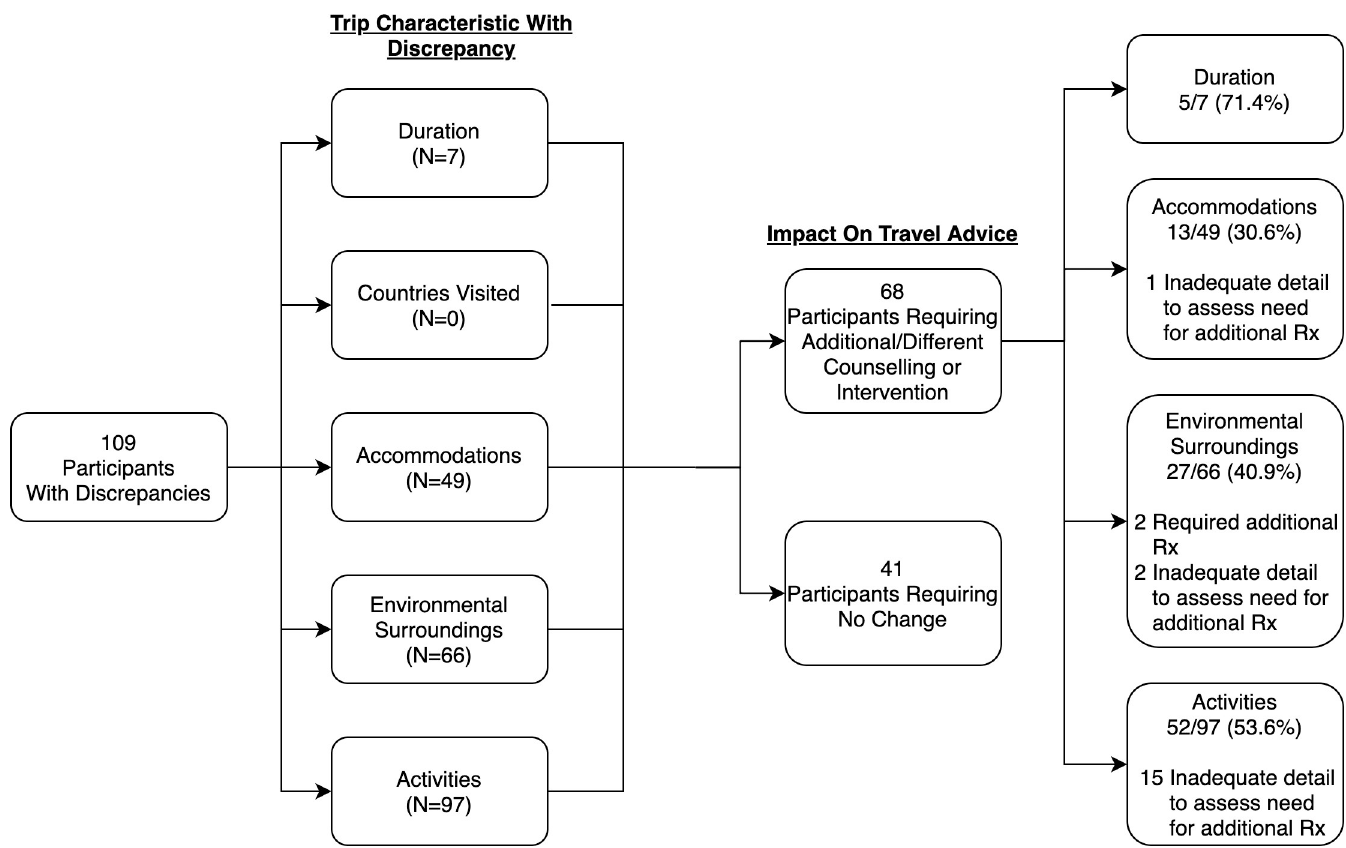
Fig 2. Travelers reporting discrepant trips (counts/proportions) (N = 119). � Participants could report discrepancies in > 1 trip characteristic. A total of 76 individuals had discrepancies in more than one trip